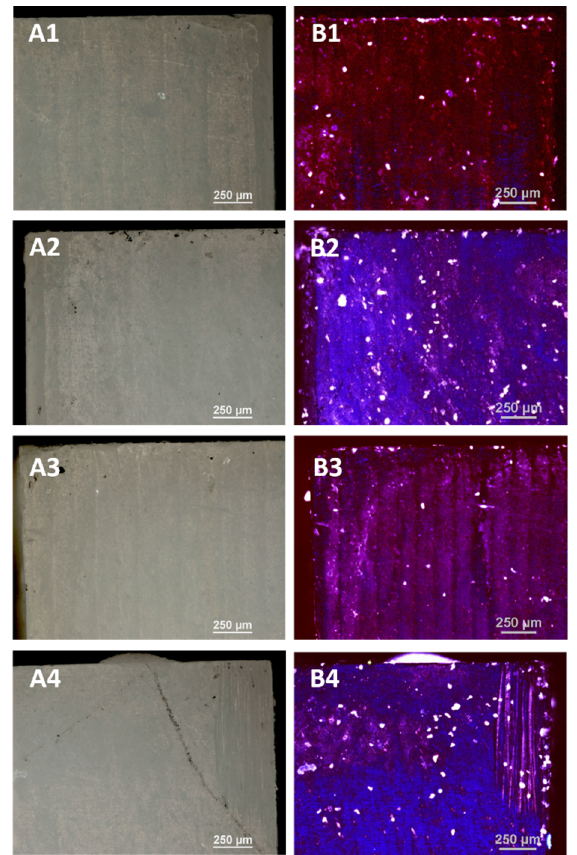
Figure 2. The micrographs of the surface of the zirconia samples made with the use of an optical microscope: ( A1 ) untreated control sample; ( A2 ) after irradiation with L1; ( A3 ) after irradiation with L2; ( A4 ) after irradiation with L3. The micrographs made from the surface of the zirconia sample with the use of a confocal microscope with a laser wavelength of λ = 408 nm: ( B1 ) the control sample; ( B2 ) after irradiation with L1; ( B3 ) after irradiation with L2; ( B4 ) after irradiation with L3.